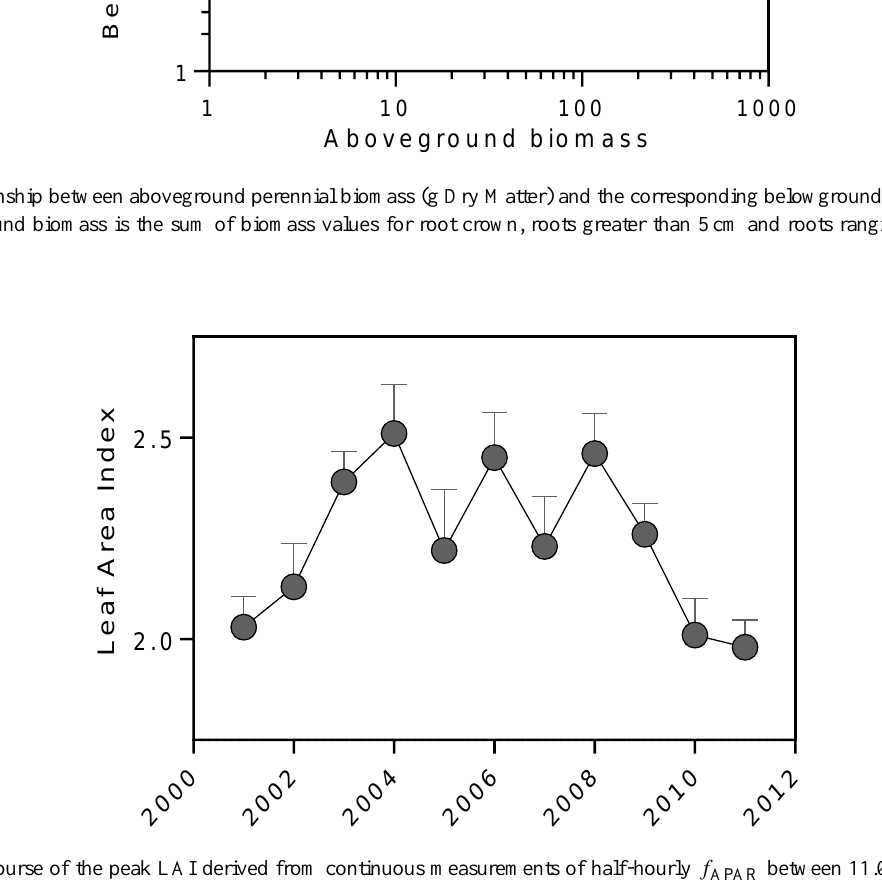
Figure A2. Time course of the peak LAI derived from continuous measurements of half-hourly f APAR between 11.00 a.m. and 1.00 p.m. from DOY 205 to 225. The stem area index (SAI) was estimated by image processing of hemispheric photography and assumed constant for the whole period and equal to 0.5. The relationship between leaf area index and water stress integral (WSI) is statistically